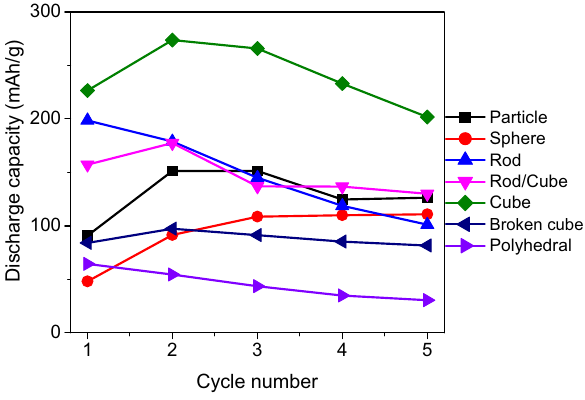
Figure 4. Discharge capacities of Fe 2 O 3 /AB electrodes in KOH